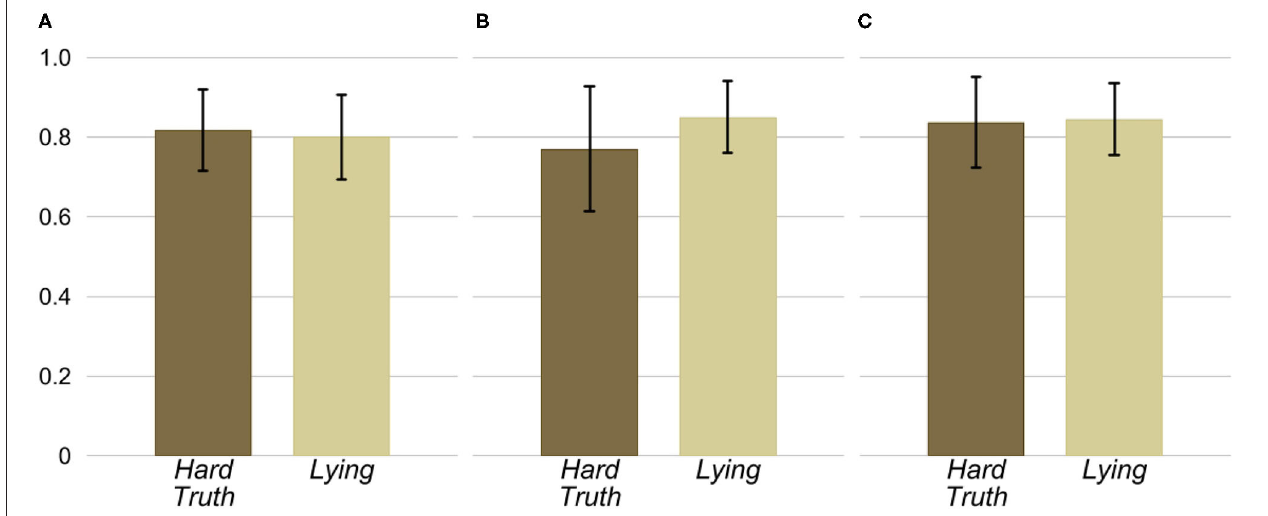
FIGURE 3 | Senders’ average belief of the likelihood that a receiver follows the message depending on the condition and treatment. (A) Baseline. (B) Face to Face. (C) Face to Face & Information. We find a similar result in the Face to Face